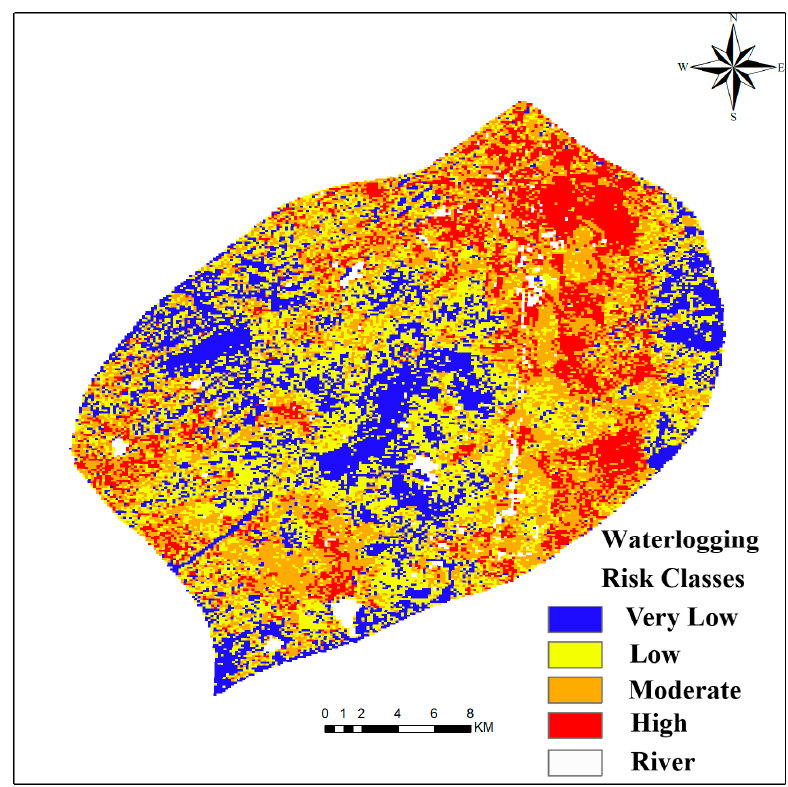
Figure 8. Urban waterlogging disaster risk zoning map.